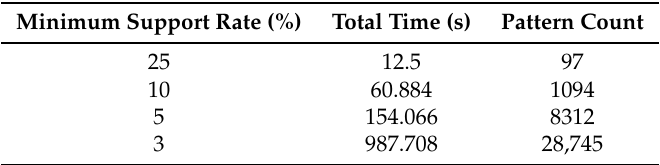
Table 2. Results by the sequence mining parameter.